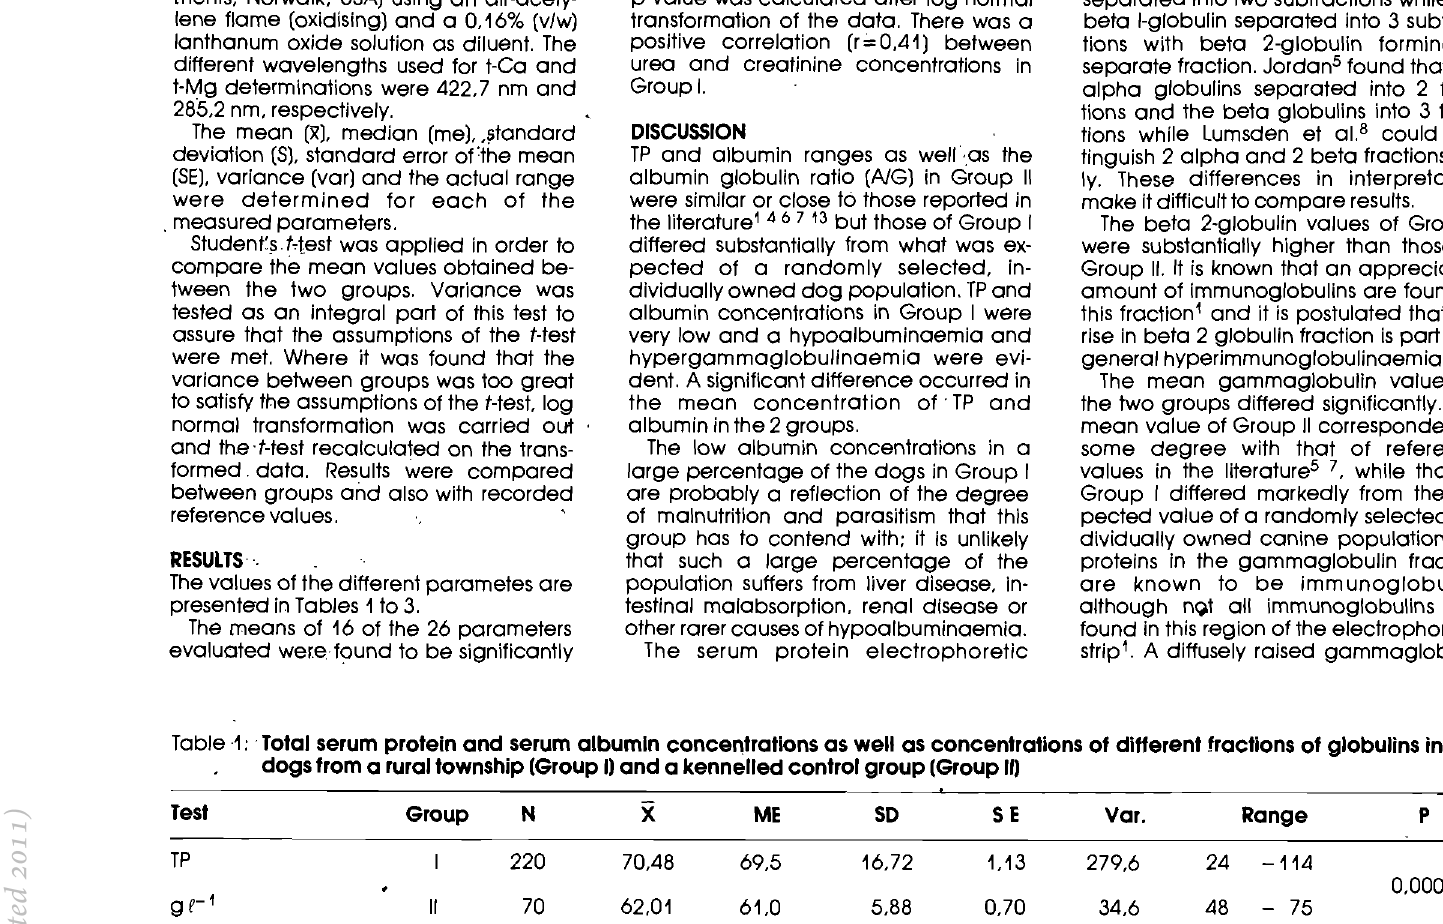
Table 1 : Total serum protein and serum albumin concentrations as well as concentrations of different fractions of globulins in 220 dogs from a rural township (Group I) and a kennelled control group (Group II) Test